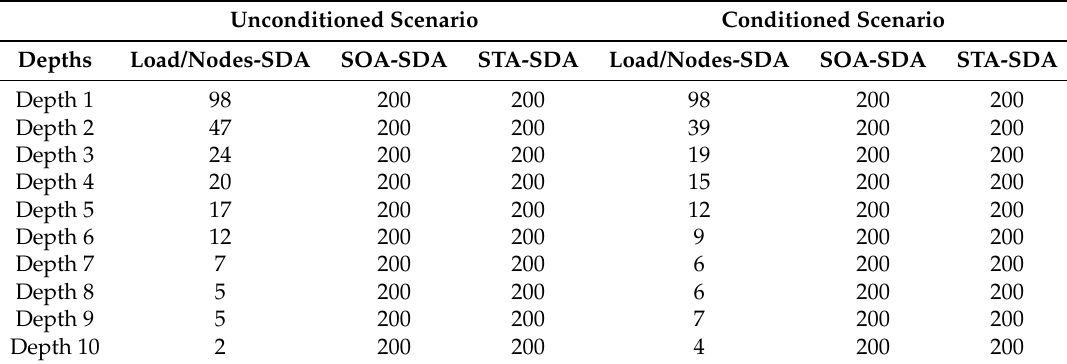
Table 6. Buffer size for cluster-heads (per depth).